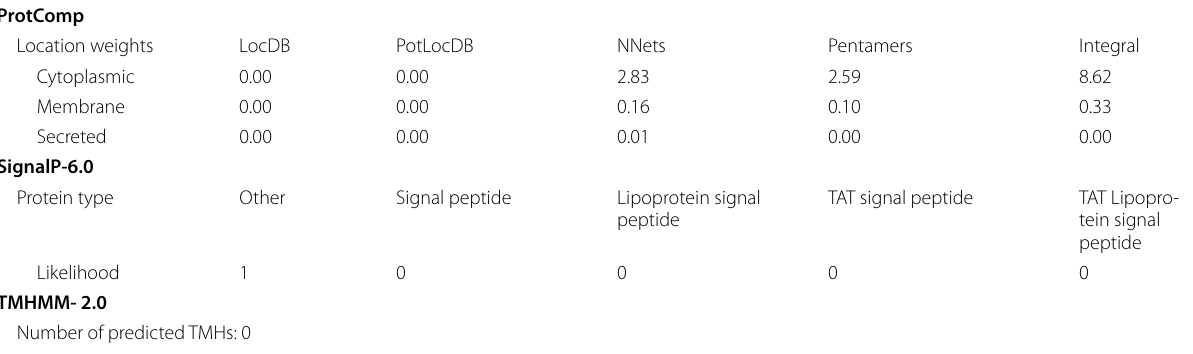
Table 3 Protein localization analysis by different